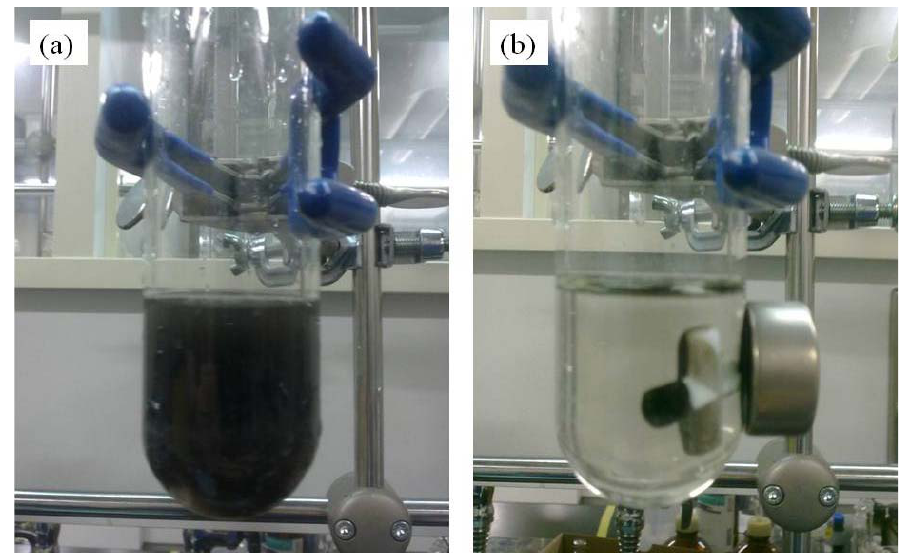
Figure 5. (a) The composite dispersed in water during the reaction. (b) Magnetic recovery of the composite after the reaction, using a strong external neodynium magnet.